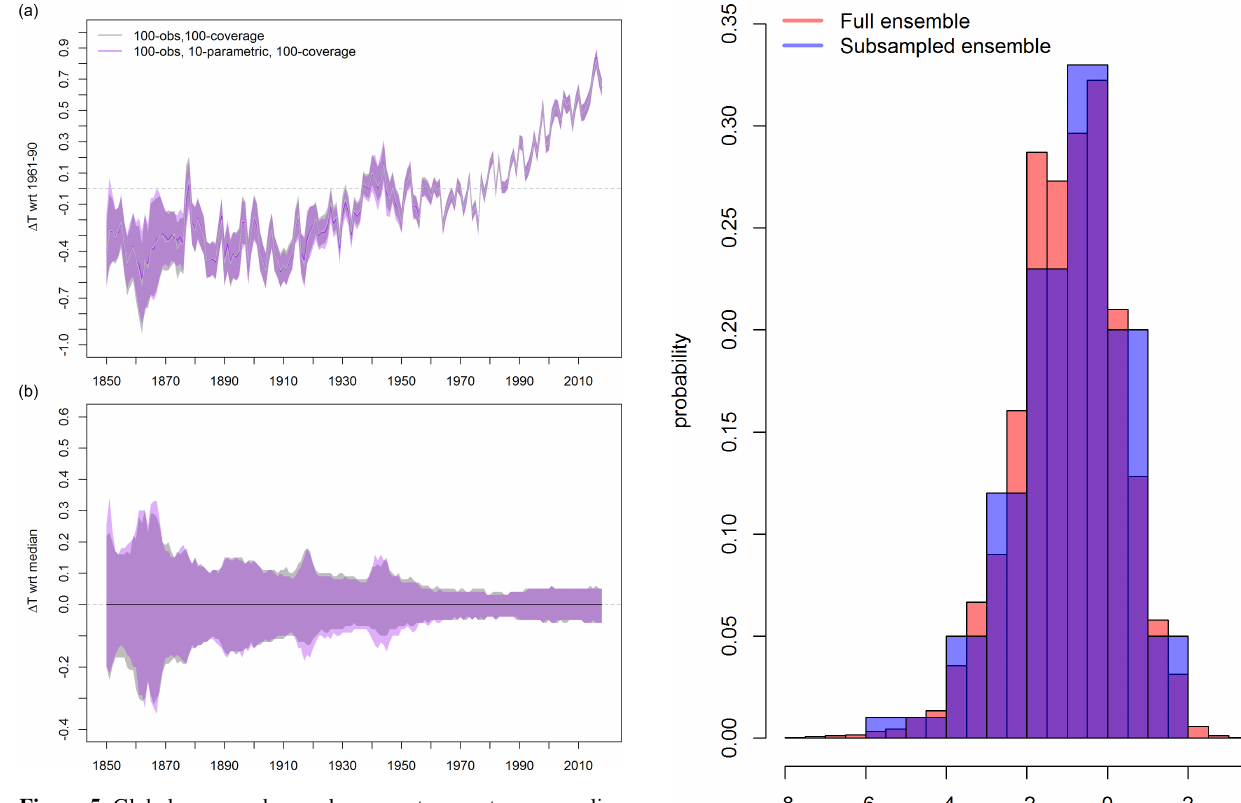
Figure 5. Global mean and annual average temperature anomalies in degrees Celsius with respect to the (a) 1961–1990 baseline and (b) median. The 95% credible (purple) and confidence (gray) in- terval estimates are based on the data set created in Ilyas et al. (2017) and the hyperparameter ensemble and the data set created in Sect. 4.3.